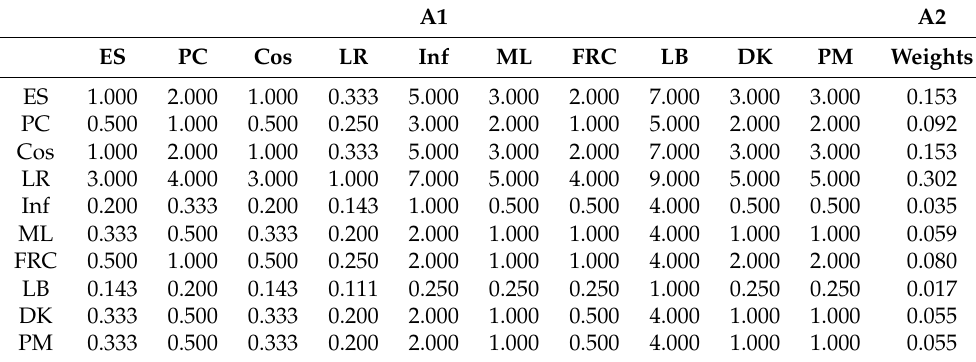
Table 5. Pairwise comparison of the